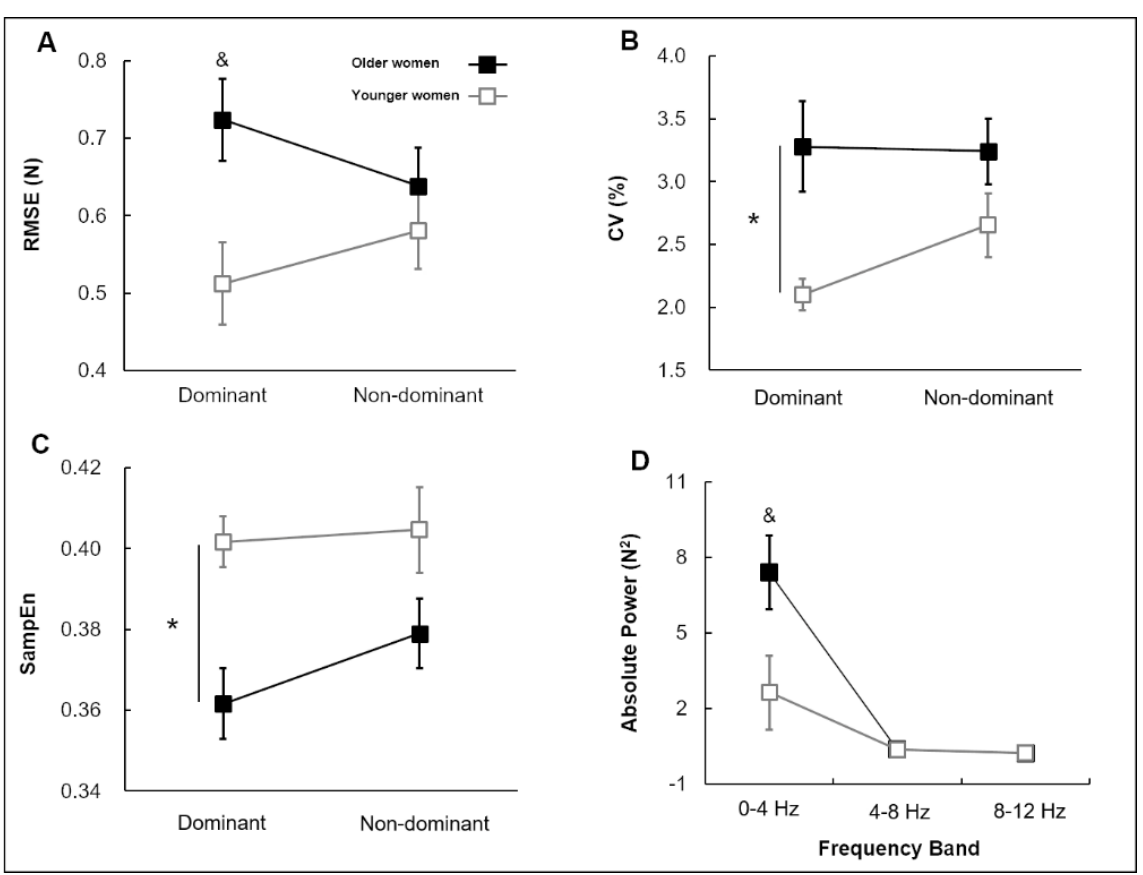
Figure 3: Force control for group and hand conditions ( M±SE ). ( A ) Force error (RMSE) showing a sig- nificant Group × Hand Condition interaction. ( B ) Force variability (CV) showing Group main effect. ( C ) Force regularity (SampEn) showing Group main effect. ( D ) Absolute power indicating a significant Group × Hand Condition × Frequency Band interaction. Asterisk (*) indicates a significant difference between groups. Ampersand (&) signs denote a significant difference between hand conditions. ( P <